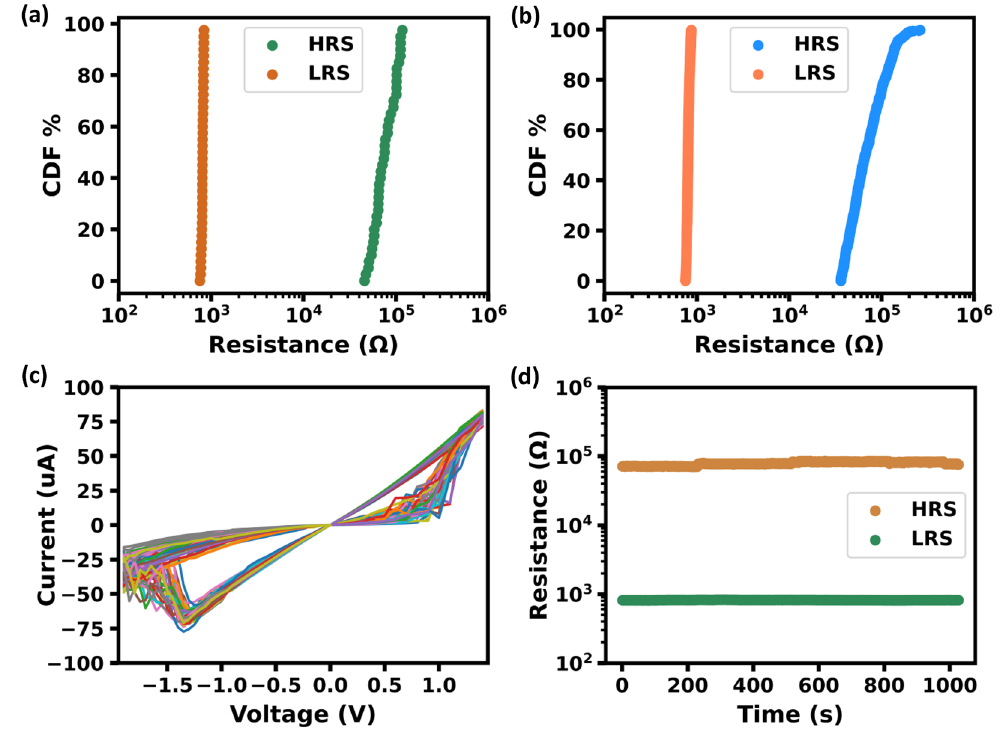
Figure 4. ( a ) Cumulative distribution function (CDF) of resistance of the high resistance state (HRS) and low resistance state (LRS) of 40 memristors; ( b ) typical CDF of cycle-to-cycle variation of both HRS and LRS of a memristor (500 cycles); ( c ) typical hysteresis characteristics of a memristor for 50 repeated measurements; and ( d ) typical retention characteristic of a